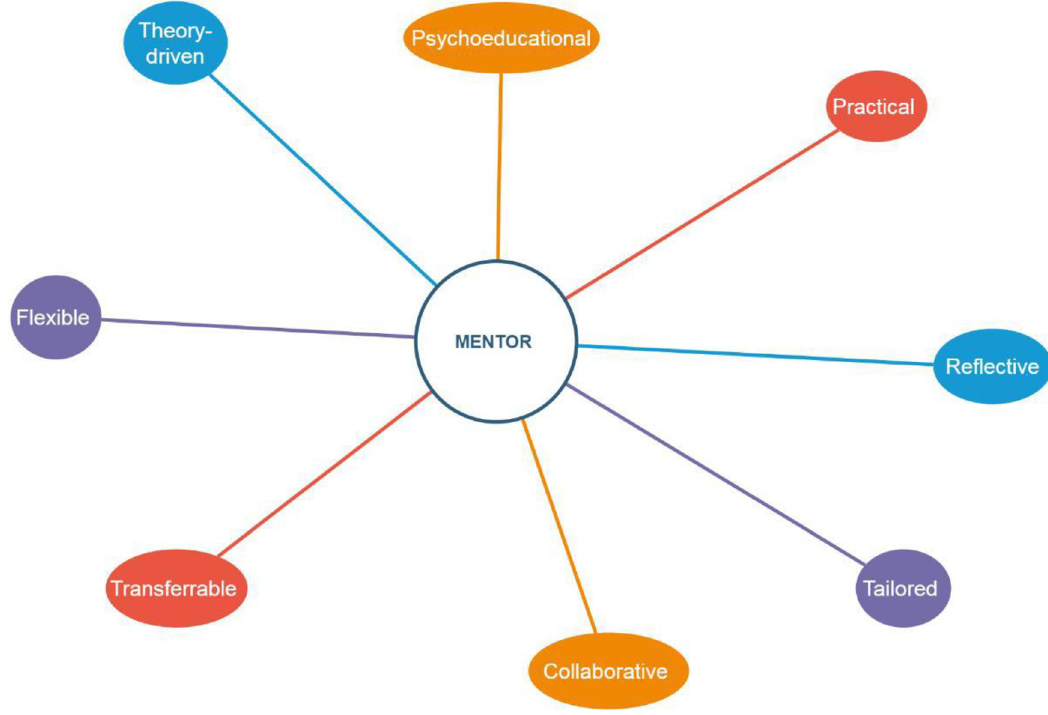
Fig 2. Principles of